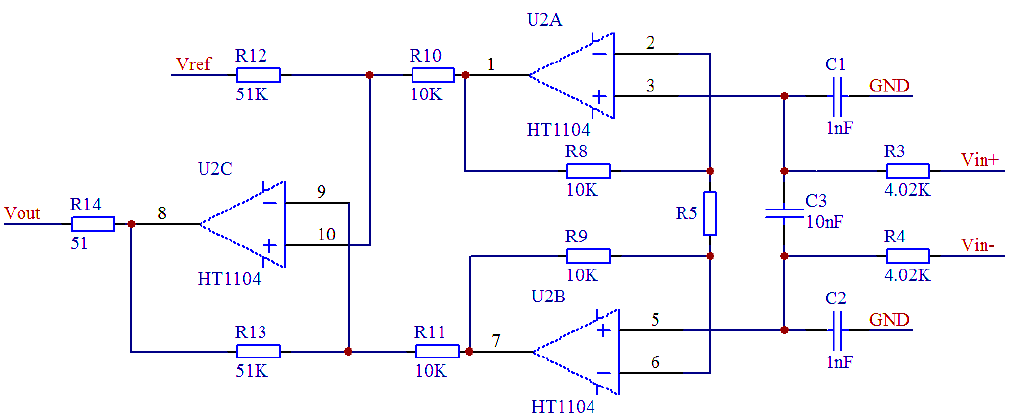
Figure 13. Schematic of a high-temperature signal-conditioning circuit.